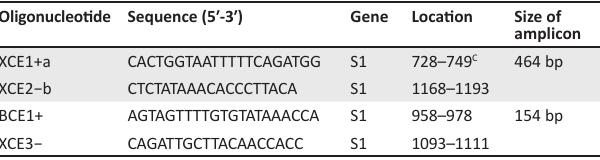
Source : Table adapted from Adzhar et al ., 1997’s article Molecular analysis of the 793/B serotype of infectious bronchitis virus in Great Britain Published in Avian Pathology a, Positive sense oligonucleotides; b, negative sense oligonucleotides; c, the numbers correspond to the nucleotide positions in the indicated references; bp, base